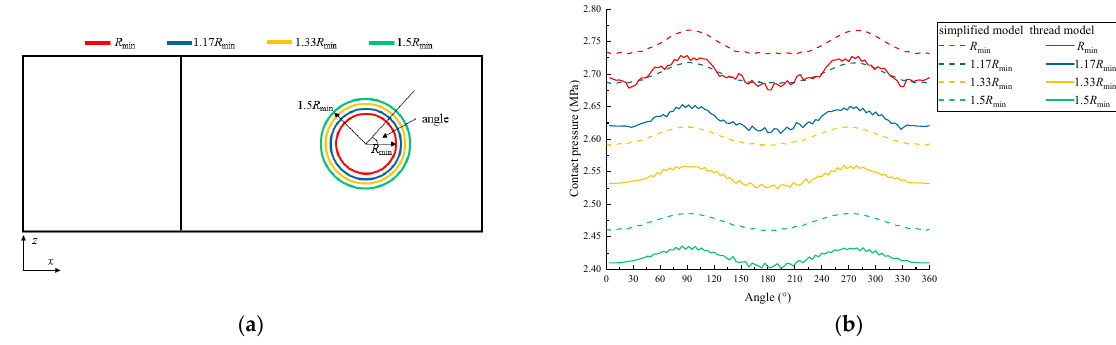
Figure 17. Pressure distribution on the inter-plate surface: ( a ) scanning paths on the inter-plate surface, ( b ) the pressure distribution of the two models.